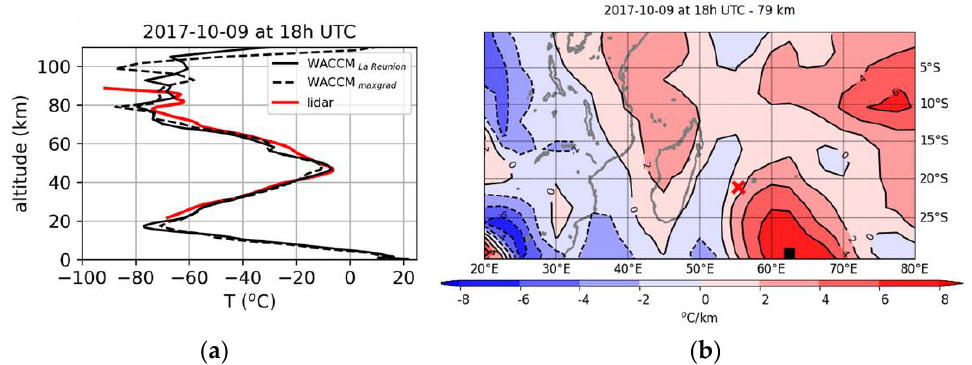
Figure 9. Spatial extension of the inversion feature: ( a ) Vertical temperature profiles extracted from WACCM simulations above La Réunion (black solid line) and where the temperature gradient is maximum “maxgrad” at 79 km height (black dashed line) within ± 10° around La Réunion on 9 October 2017. The red line refers to the smoothed lidar profiles during the corresponding night, shown at a 5 km vertical resolution; ( b ) Temperature gradient maps at 79 km altitude showing the location of the inversion layer. The red cross and the black square locate La Réunion and the profile “maxgrad”, respectively .